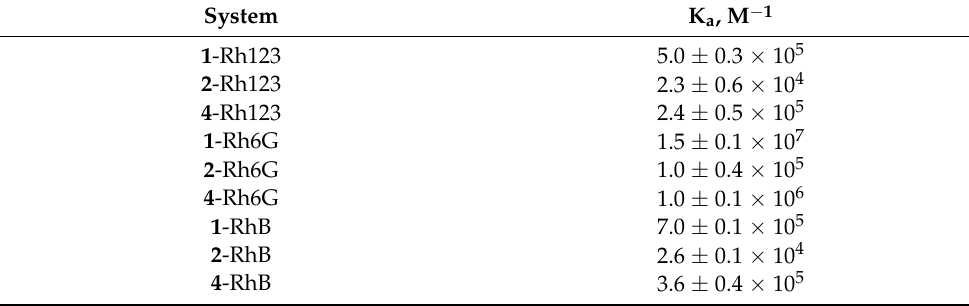
Table 1. a Association constants (K a ) of calixarene 1 , 2 and 4 complexes with rhodamine dyes.